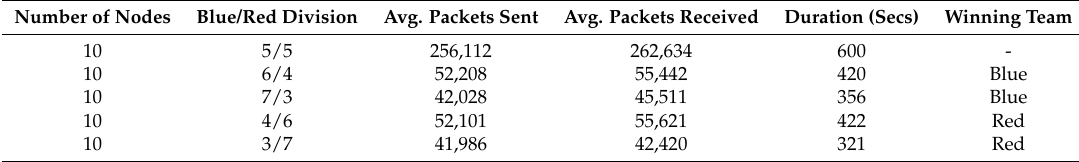
Table 1. Results following a 10 mote Blue vs. Red simulation using the provided scenario. Number of Nodes Blue/Red